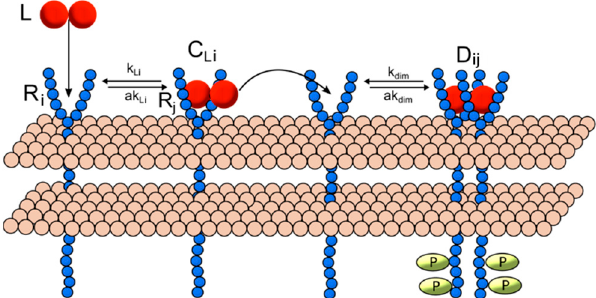
Figure 1. Receptor dimerization reaction scheme. Dimerization includes the following reactions for any two receptor monomers with indices i and j : ligand L binds a non-ligated receptor monomer R i , with on-rate k Li and off-rate ak Li , forming a ligand-receptor complex C Li . This complex can then dimerize with another un-ligated receptor monomer R j , with forward rate k dim and reverse rate ak dim , to form the dimer D ij . Note that i = j indicates a homodimer and i ≠ j indicates a heterodimer.